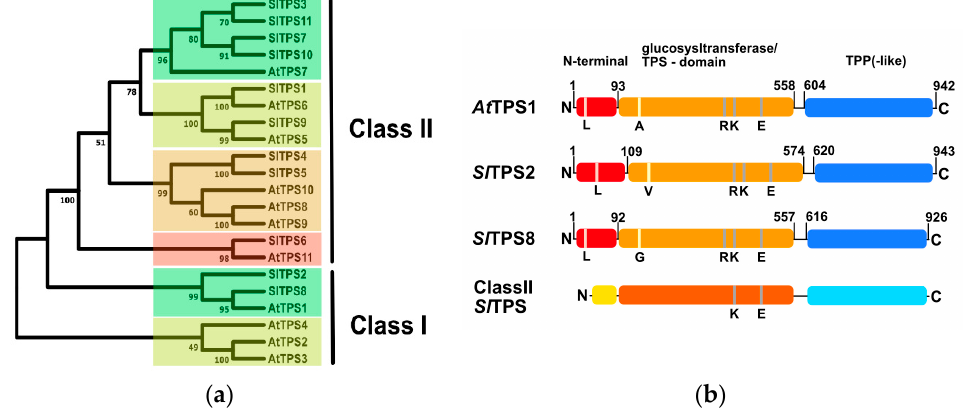
Figure 1. Comparison of the TPS families of tomato and Arabidopsis. ( a ), Phylogenetic tree of the TPS-families from tomato and Arabidopsis inferred using the Neighbor-Joining method. The bootstrap consensus tree inferred from 500 replicates. Evolutionary analyses were conducted in MEGA11 (www.megasoftware.net, accessed on 24 July 2022) ( b ), Domain structure of tomato class I TPS proteins in relation to Arabidopsis TPS1. For comparison, the general domain structure of tomato class II TPS proteins is indicated. Domains were predicted using the InterPro online tool (https://www.ebi.ac.uk/interpro/, accessed on 1 August 2022).